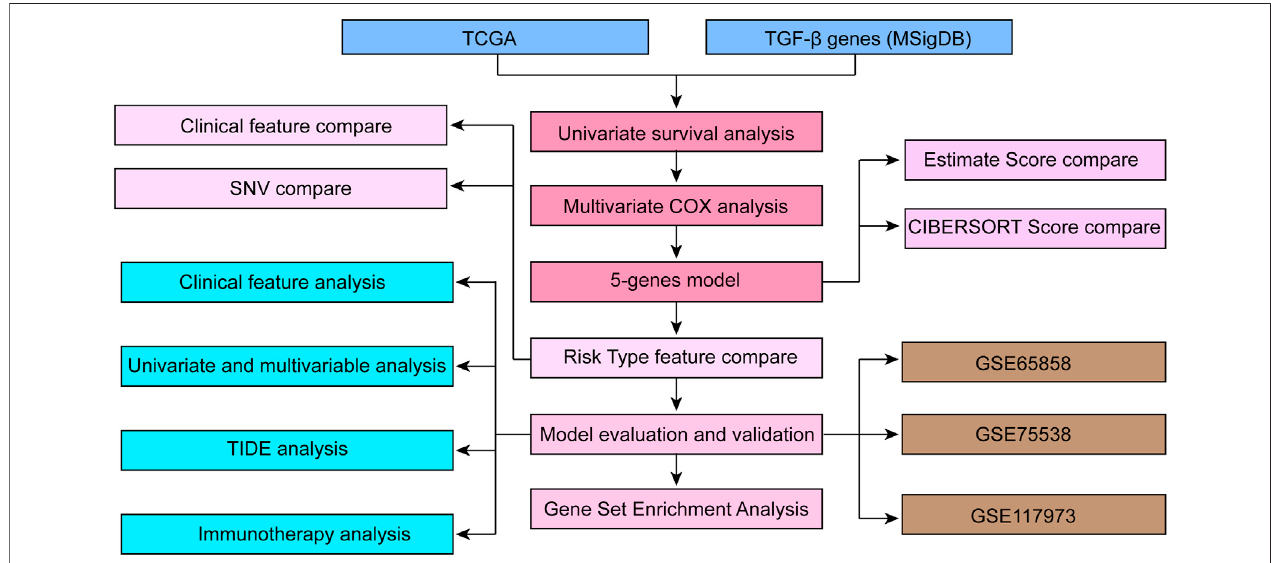
FIGURE 1 | The work fl ow of TGF- β pathway signature-associated HNSCC prognosis analysis.